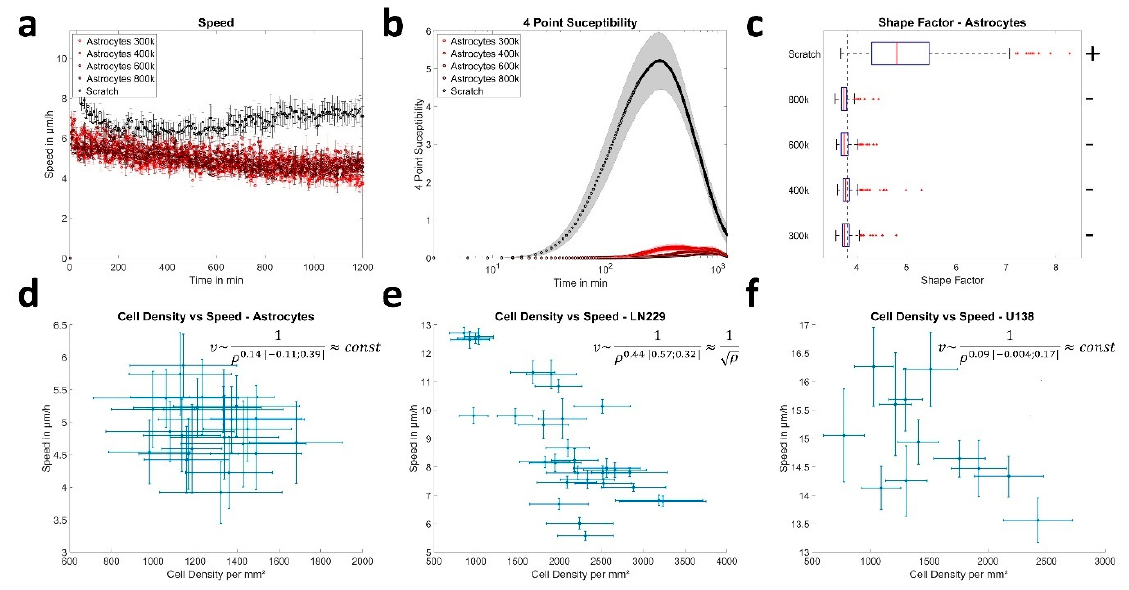
Figure 3. Cell density dependence of collective migration. ( a ) Measured mean speeds of astrocytes per field of view when seeded in different densities of 300k, 400k, 600k, 800k cells or subjected to a scratch, measured for 18 or 20 (scratch) fields of view. ( b ) Illustration of the 4-point susceptibility over the whole measurement time. Peak positions of the 4-point susceptibility represent the average life time of collectively moving packs of cells. Sample sizes are identical to ( a ). ( c ) Illustrates the difference in shape factor for different seeding densities of astrocytes and during the wound healing assay. The dotted line shows the critical value of 3.81 predicted by the vertex model. Below cells are considered to be jammed. “+” and “ − “ depicts if shape factors are significantly larger or smaller than the critical value, with p < 0.0001 for all instances, as tested by sign test for 256, 269, 234, 183 or 386 astrocytes for seeding densities of 300k, 400k, 600k, 800k cells or the scratch. ( d – f ) Plot of the cell density over the speed for astrocytes, LN229 and U138 cells. Formulas show the scaling behavior of the speed v with cell density δ . Values in brackets denote 95% confidence intervals. ( a ), ( b ), ( d – f ) Error bars and shaded areas depict the standard error of the mean. ( c ) Box plots show the median (red line), 25 and 75 percentile (box), non-outlier range (whiskers) and outliers (red dots).